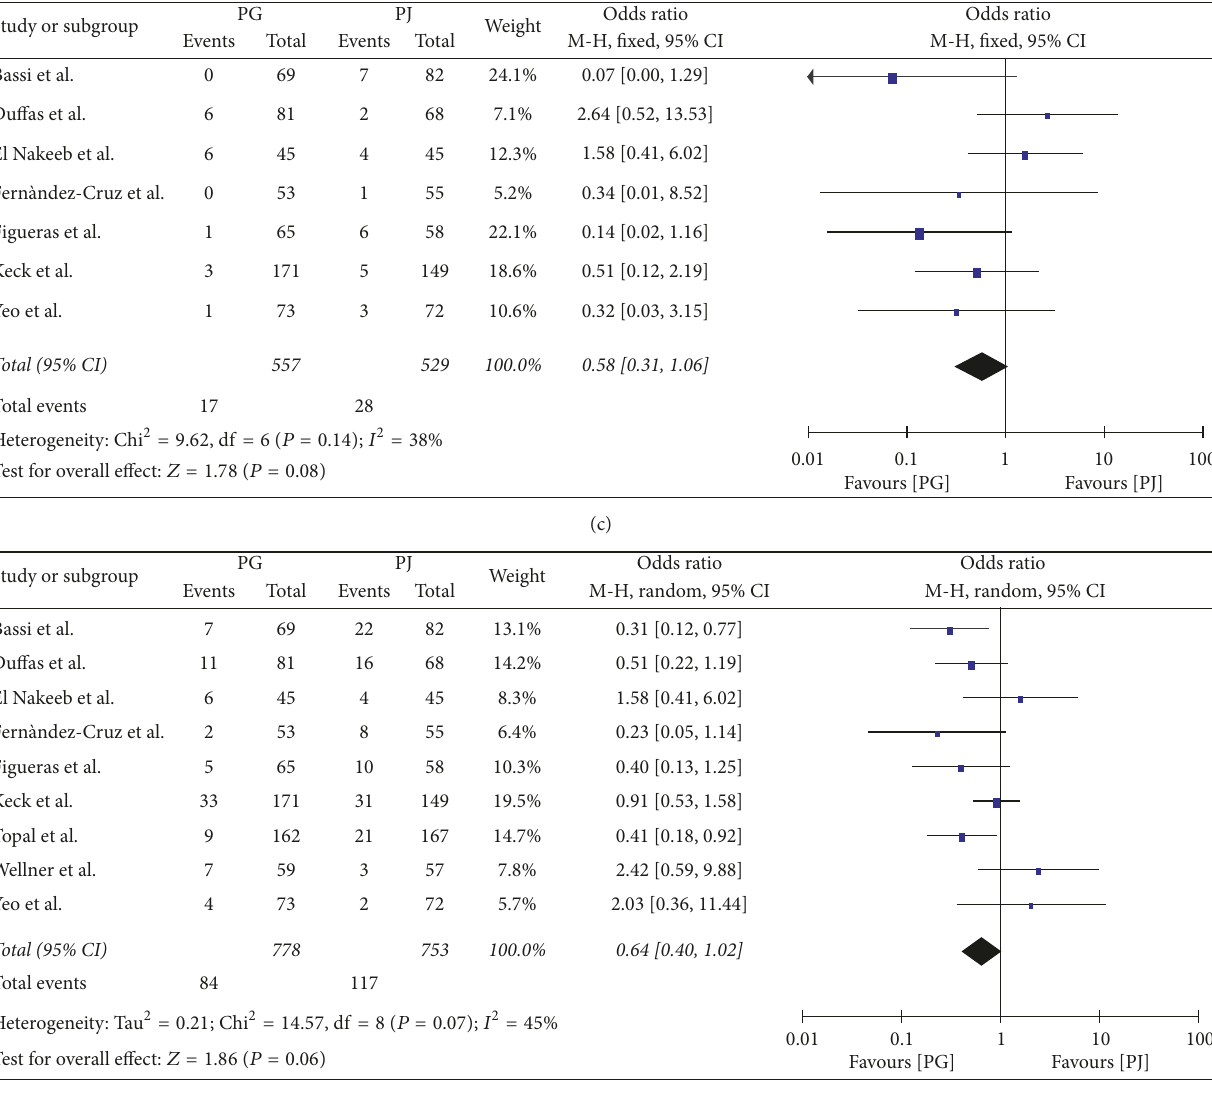
Meta-analysis of the data showed no statistically significant ( 𝑃 = 0.33 ) difference between the